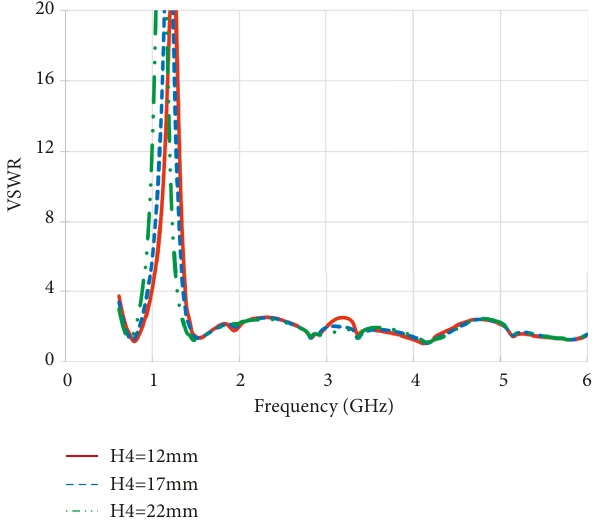
Figure 8: Effect of the long-branch vertical folded arm height (H4) on the antenna